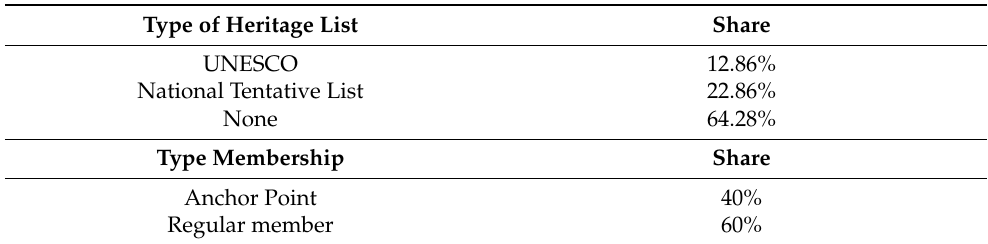
Table 1. The share of research subjects inscribed on a heritage protection list and type of membership in ERIH.